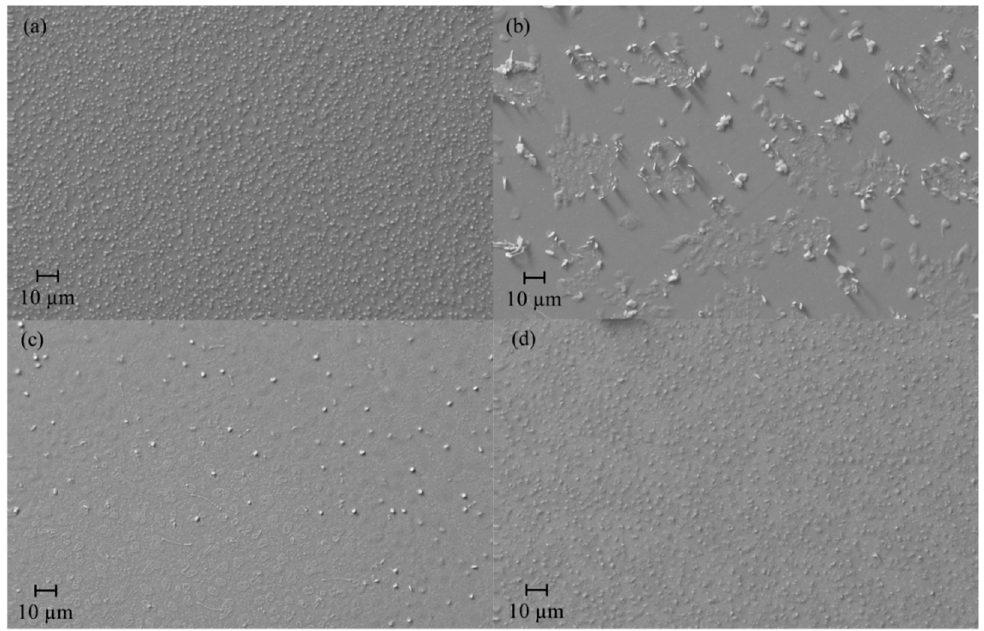
Figure 3. SEM images of polished KCS-1 melt glass slices after 2 h hydrothermal exposure in air with 7% H 2 O at ( a ) 300 °C,( b ) 500 °C, ( c ) 600 °C, and ( d ) 700 °C. Separate samples were used for each testing condition (reproduced from [31]).